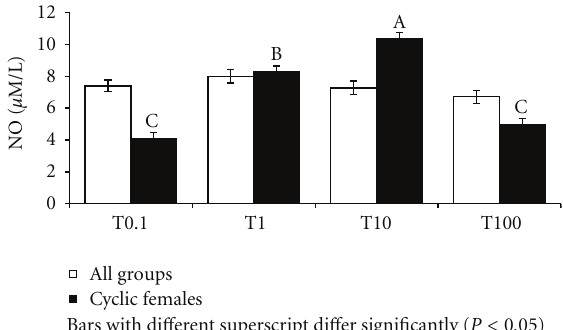
Figure 7: NO in culture supernatant supplemented with di ff erent levels of testosterone in Murrah bu ff